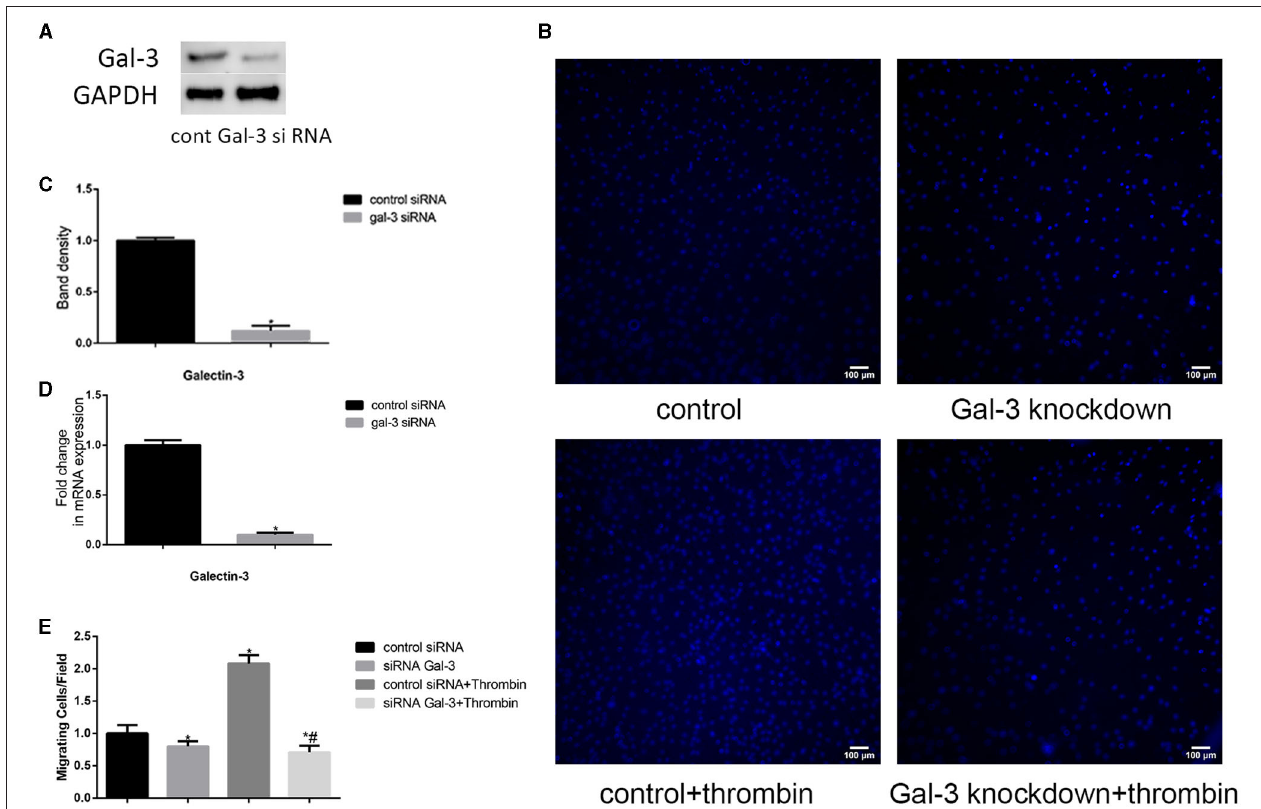
FIGURE 2 | Gal-3 mediated thrombin-induced VSMC migration. VSMCs were transfected with gal-3 siRNA for 24h. The mRNA and protein expression levels of gal-3 were measured by qRT-PCR and Western blotting separately. Western blot and qRT-PCR results of gal-3 are shown (A,C,D) . Band density of VSMCs transfected with scramble siRNA was chosen as a reference and set to 1. * p < 0.05 vs. the control. After transfection with either control or gal-3 siRNA for 24h, VSMCs were added in the upper chamber. After treatment with thrombin (2 U/ml) for 24h in the lower chamber, migrated cells from the upper chamber to the lower surface were counted in five non-overlapping fields under a microscope ( × 100) (B,E) . These blue stains are the nucleus of VSMCs that were stained with DAPI. Control siRNA transfected VSMCs were chosen as a reference and set to 1. * p < 0.05 vs. control; # p < 0.05 vs. thrombin.